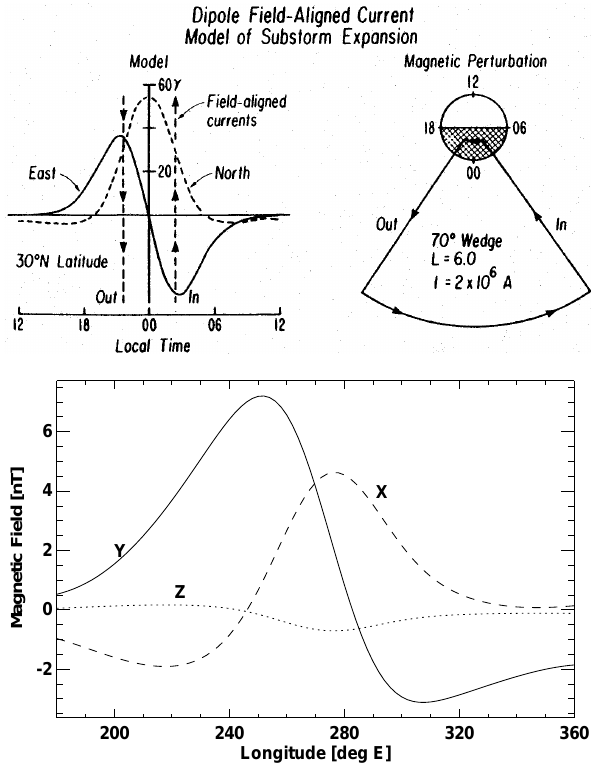
Fig. 7. (a) Model longitude profile across the low latitude region ob- served during substorm expansive phase conditions (after McPher- ron et al., 1973). Note that 1 gamma ( γ) =1nT. The model profile for the line current system shown on the right side of the figure satisfies observations of the polarities of magnetic bays at middle latitudes documented by Rostoker (1966) among others. (b) Model longitude profile of the magnetic perturbation at latitude 45 ◦ for our change in the directly driven current system. Magnetic midnight is at 270 ◦ E. The high degree of similarity between these two profiles of the hor- izontal components of the magnetic field perturbation in Figure 7 strongly supports our model of the process in terms of representing a plausible explanation of the development of the substorm current